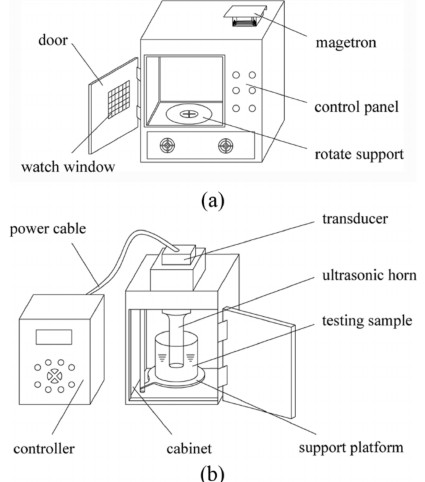
Figure 9. ( a ) Microwave reactor; ( b ) Ultrasonic extraction device.